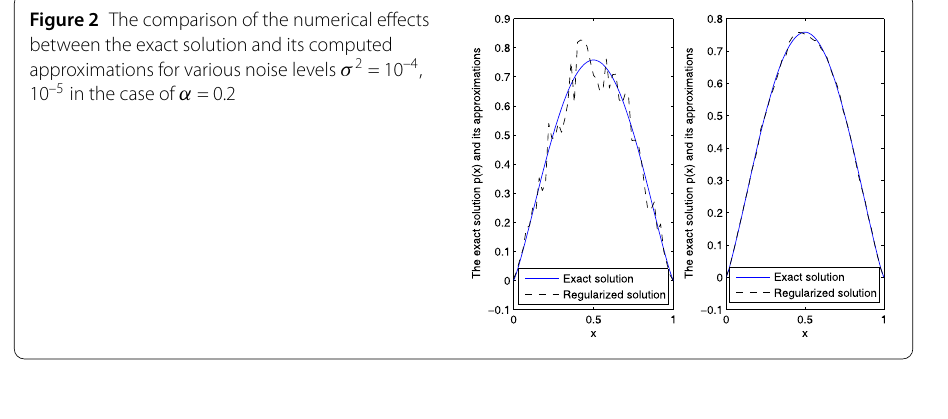
Figure 3 The comparison of the numerical effects between the exact solution and its computed approximations for various noise levels σ 2 = 10 –4 , 10 –5 in the case of α =